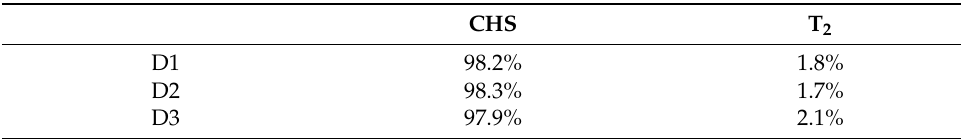
Table 5. The relative contribution of the central heating supply (CHS) and air temperature (T2) in changing equivalent heat island areas.